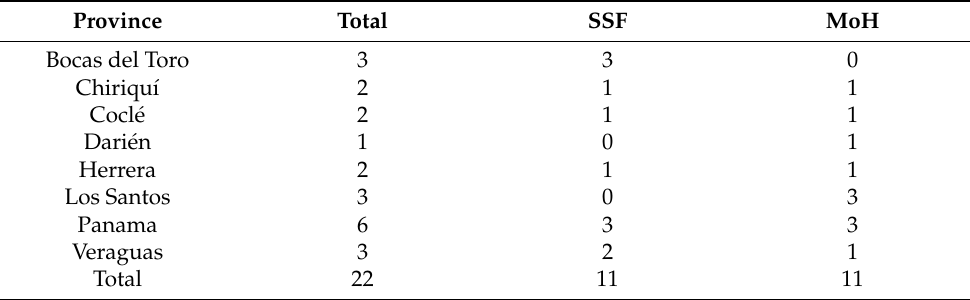
Table 1. Distribution by province and financial system of the hospitals in the sample.